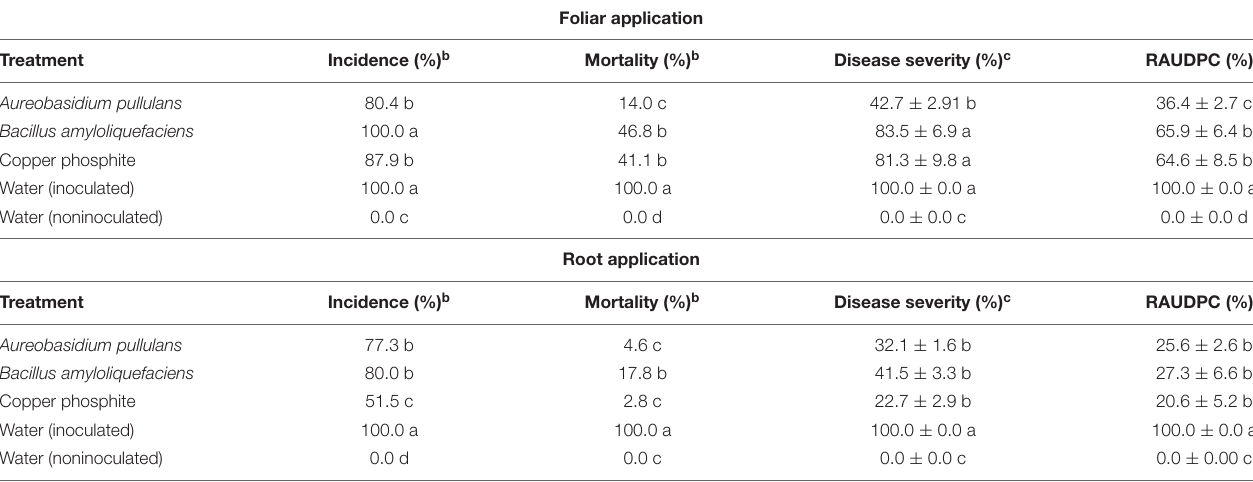
TABLE 2 | Disease-related parameters for olive plants grown in artificially infested substrate with the defoliating Verticillium dahliae isolate V180 and treated with several products by spraying (foliar application) or irrigation (root application) a .